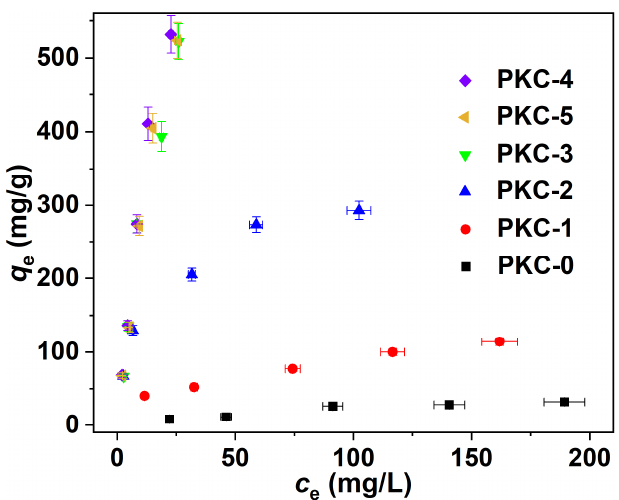
Figure 5. The equilibrium adsorption capacities of biochars at different initial OTC concentrations.